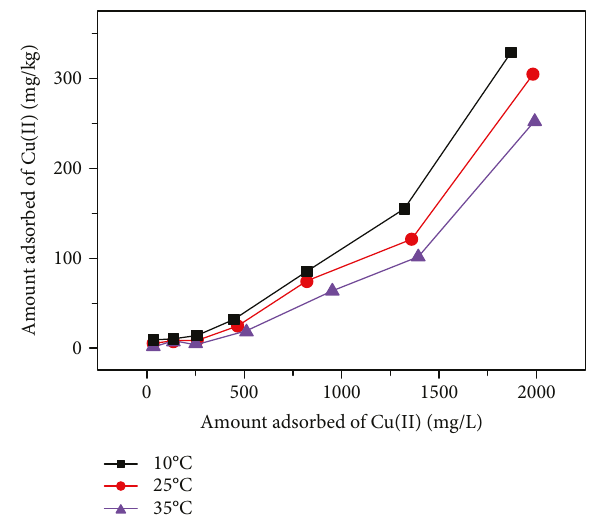
Figure 12: Desorption of Cu(II) in single-metal and binary-metal